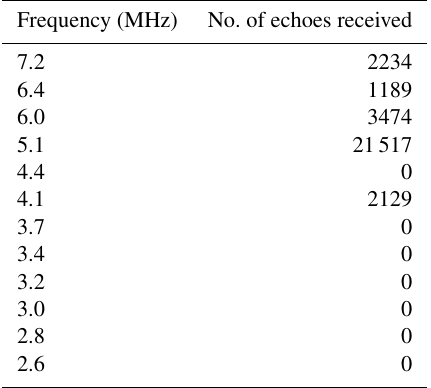
Table 2. Number of ionospheric echoes received between 28 Febru- ary and 15